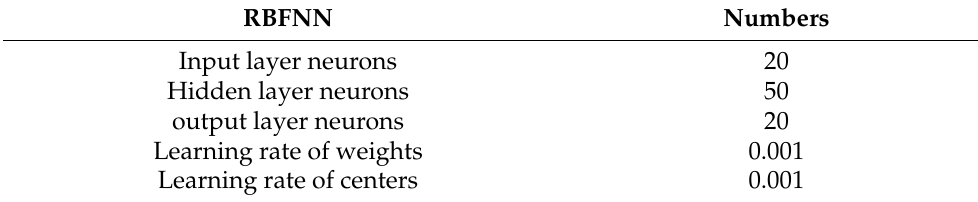
Table 2. RBF neural network structure with a Gaussian activation